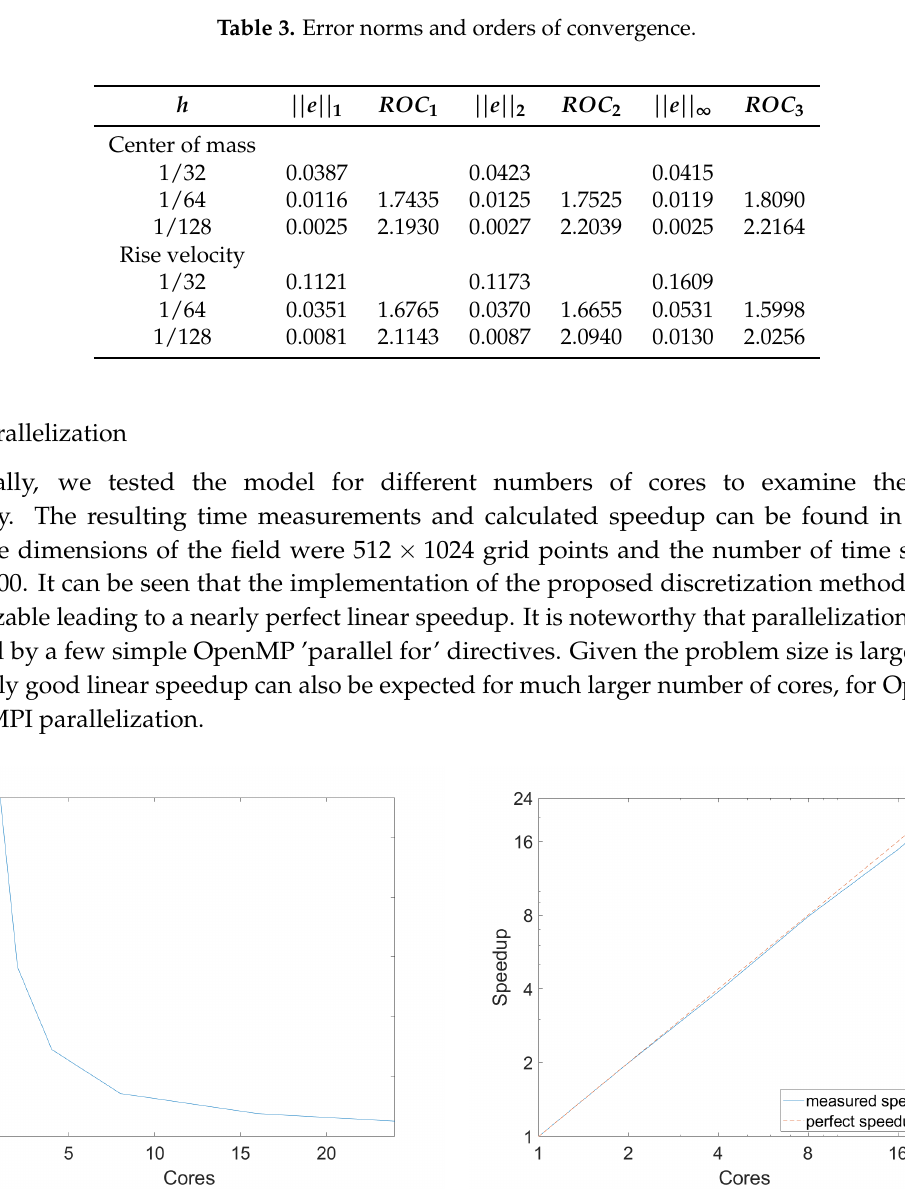
Figure 4. Parallel scaling: Time measurements in seconds (left) and calculated speedup (right) of simulations with grid size 512 × 1024 and a total time step number of 3000. The scales of the right plot are logarithmic and the speedup is calculated from mean execution time of three distinct simulation